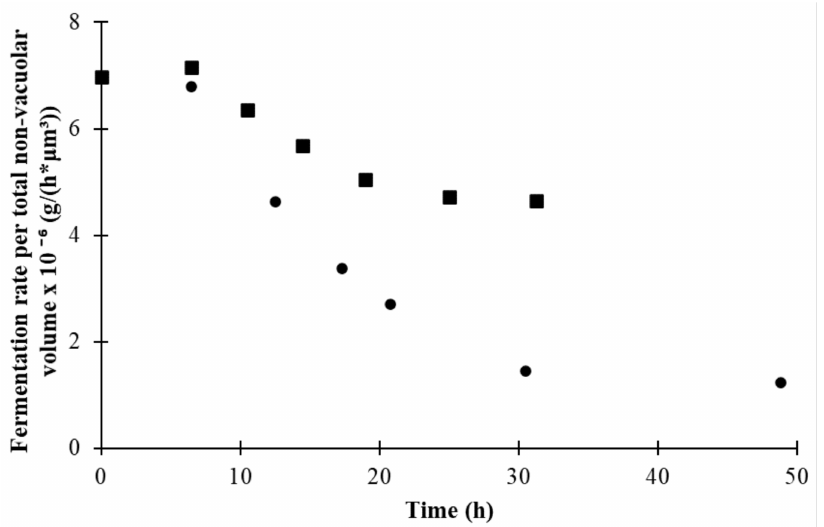
Figure 10. Fermentation rate per total non-vacuolar volume over time. Data are presented as follows: fermentation rate per total non-vacuolar volume at 30 ◦ C (circles) and 35 ◦ C